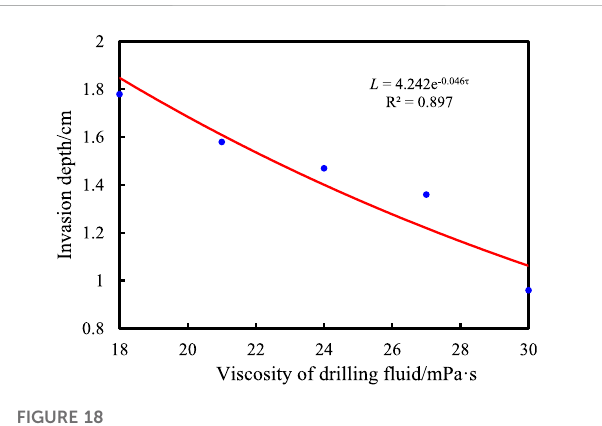
FIGURE 18 Relationship between the invasion depth of the drilling fl uid along the bedding fracture and viscosity of the drilling fl